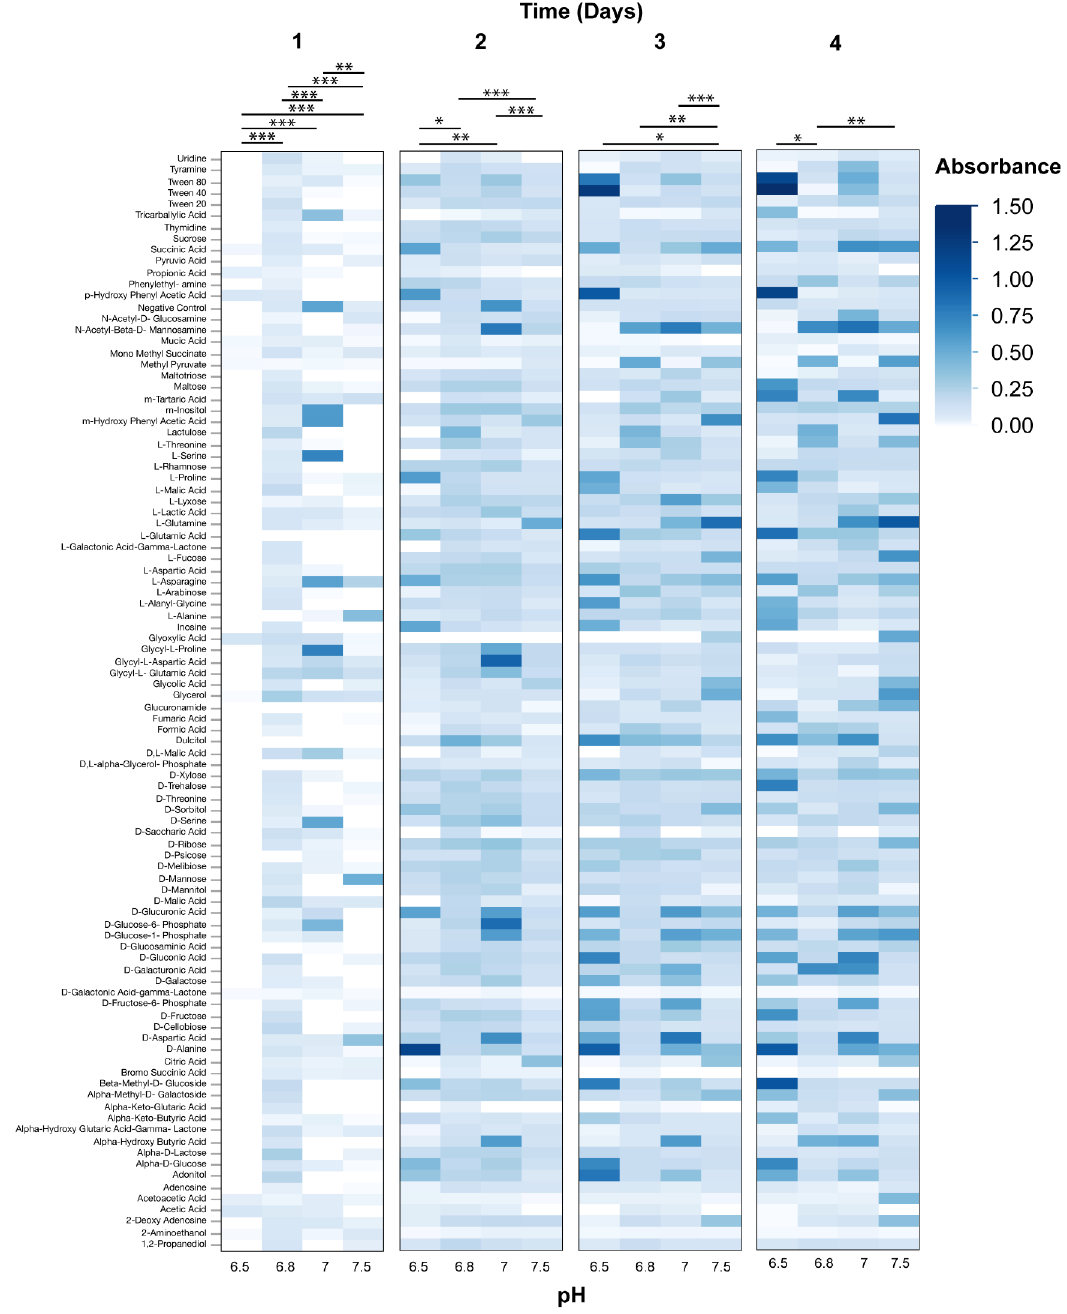
Figure 2. Heat map of PM1 phenotypic microarray data from Wolbachia isolated and maintained in Schneider’s medium supplemented with 10% FBS at different pH levels ( n = 2 for each treatment). All data were normalized by subtracting absorbance values of control plates containing Schneider’s medium only from absorbance readings of treatment plates. Significant differences between treatments are represented by horizontal bars above each column for each timepoint (t-tests, * p < 0.05, ** p < 0.005, *** p < 0.0005).